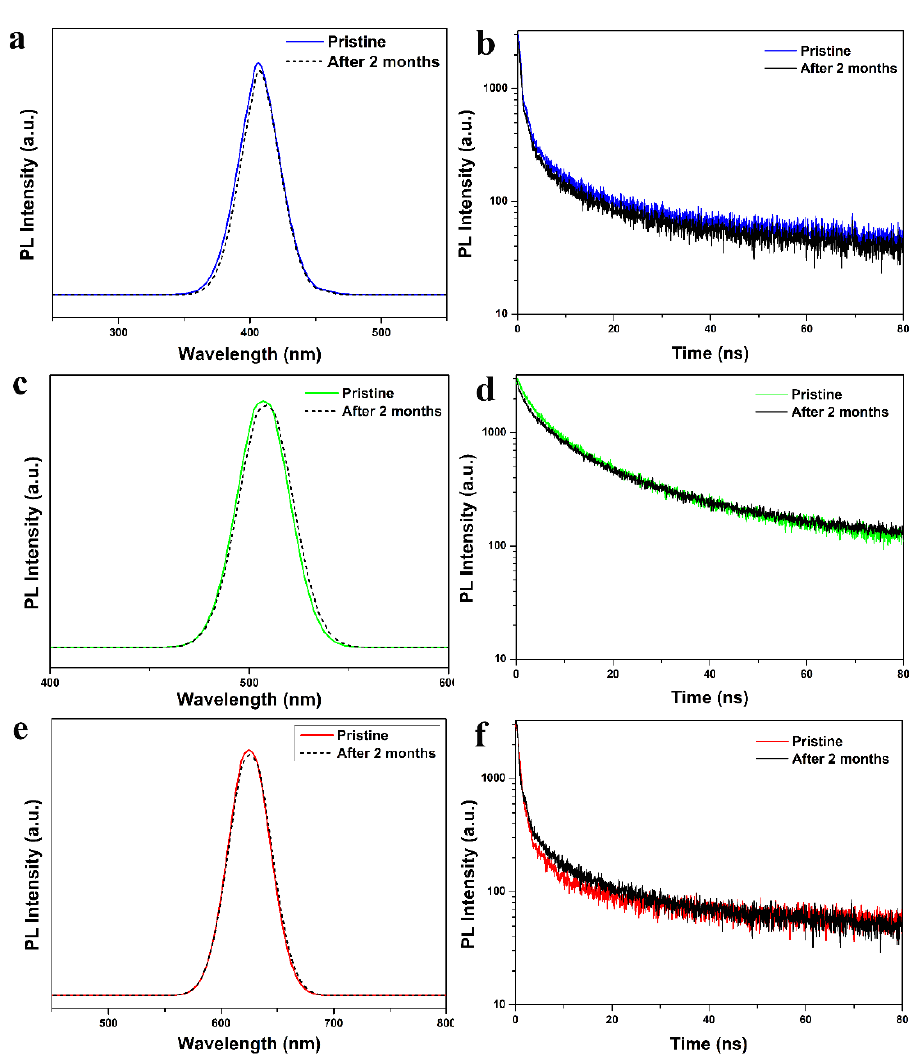
Figure 8. PL spectrum of pristine and after 60 days about ( a ) CsPbCl 3 @Cu-BDC, ( c ) CsPbBr 3 @Cu-BDC, and ( e ) CsPbI 3 @Cu-BDC. The PL emission decay curves of pristine and after 2 months about ( b ) CsPbCl 3 @Cu-BDC, ( d ) CsPbBr 3 @Cu-BDC, and ( f ) CsPbI 3 @Cu-BDC.